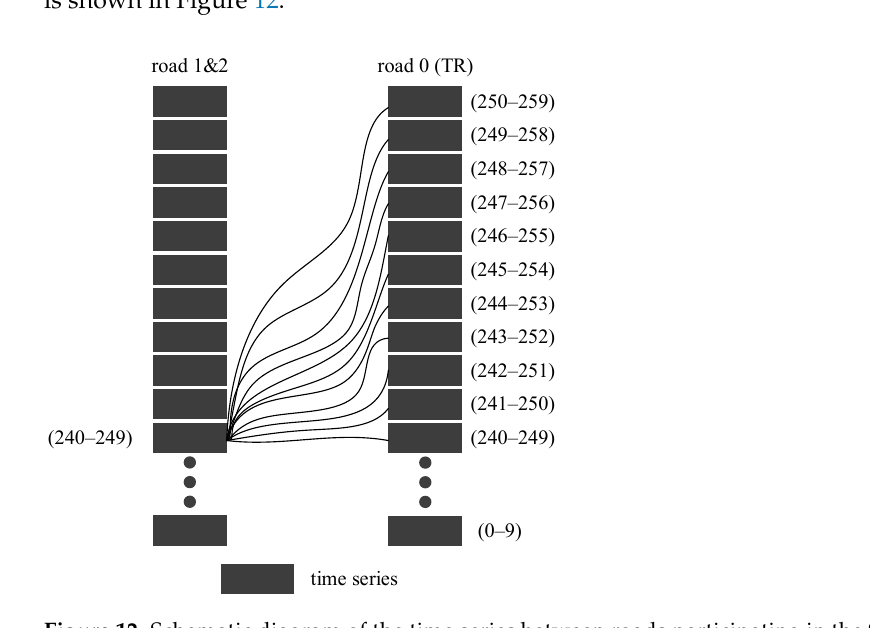
Figure 11. Correlation determined using the DCF.